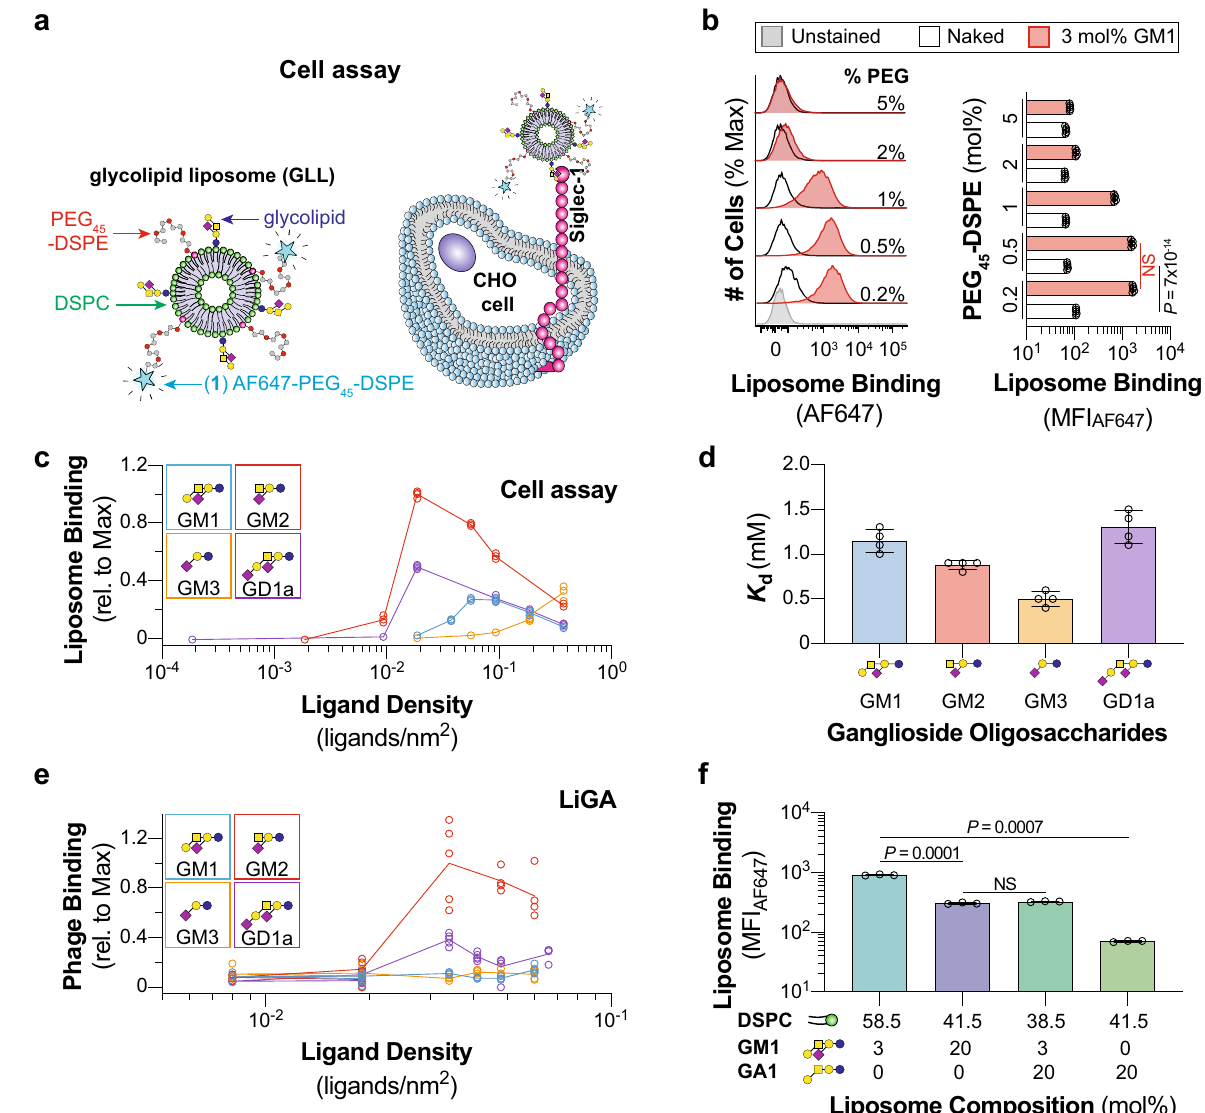
Fig. 1 | Optimizing a liposome formulation for probing Siglec – ganglioside interactions. a Schematic of the cell assay where binding between Siglec-1- expressing CHO cells and fl uorescently labeled GLLs are quanti fi ed via fl ow cyto- metry. b Representative fl ow cytometry histograms and quanti fi cation of 3mol% GM1 liposomes with varying mol% of PEG 45 – DSPE to Siglec-1 CHO cells ( n =5 technical replicates). c Binding of liposomes formulated with increasing ganglio- side (GM1, GM2, GM3, GD1a) content against Siglec-1 CHO cells ( n =4 technical replicates). d Mass spectrometry-derived dissociation constant for the interaction betweensolubleSiglec-1 and ganglioside (GM1, GM2,GM3, GD1a)oligosaccharides GM3 trisaccharide exhibited the highest af fi nity towards Siglec-1, with a K d value of 0.5±0.1mM. Therefore, factors beyond the intrinsic af fi nity of Siglec-1 to the oligosaccharide moiety of the ganglioside in fl uence the avidity of Siglec-1 for glycolipids presented in a lipid bilayer.